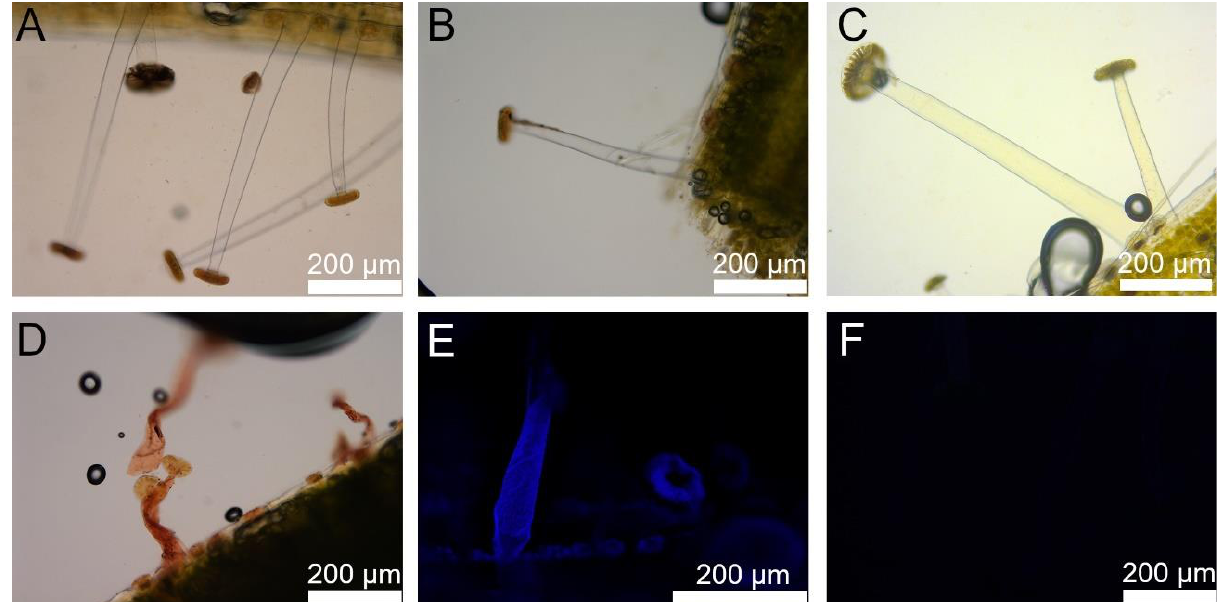
Figure 12. Results from the histological staining approaches. Image ( A ) shows unstained stalked glands as controls. Image ( B ) shows the negative result of ruthenium red staining, ( C ) the negative result of phloroglucinol staining, ( D ) the positive result of Sudan IV staining, and ( E ) the positive result of Calcofluor white staining with the corresponding negative control in ( F ).